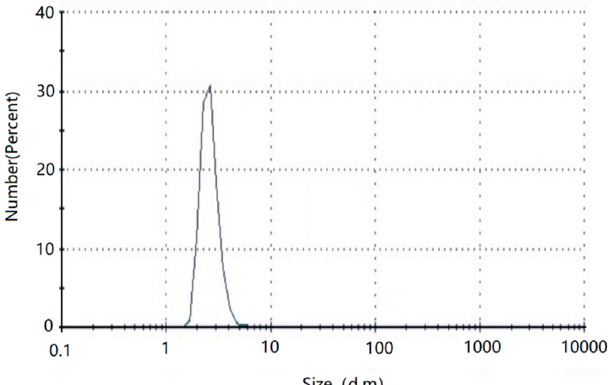
Figure 6. Hydrodynamic diameter measurement of AuNPs formed from C. sinensis peel at pH = 11 adjusted after the reaction.